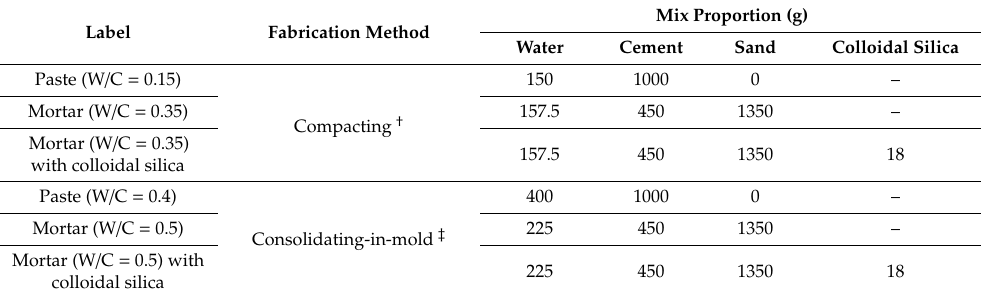
Table 2. Mix proportion of